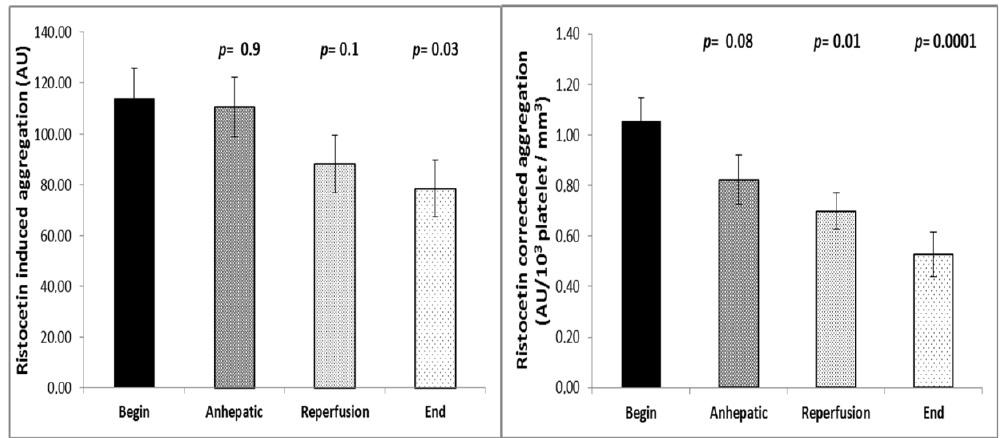
Figure 4. Time course of platelet aggregation during liver transplantation ( n = 35) using the ristocetin test without and with correction for platelet count. Both corrected and uncorrected platelet function decreases with the reperfusion of the transplant. Values are given as mean and SEM. The Mann–Whitney U-test was used to determine changes in platelet aggregation from the initial value during the course of surgery.